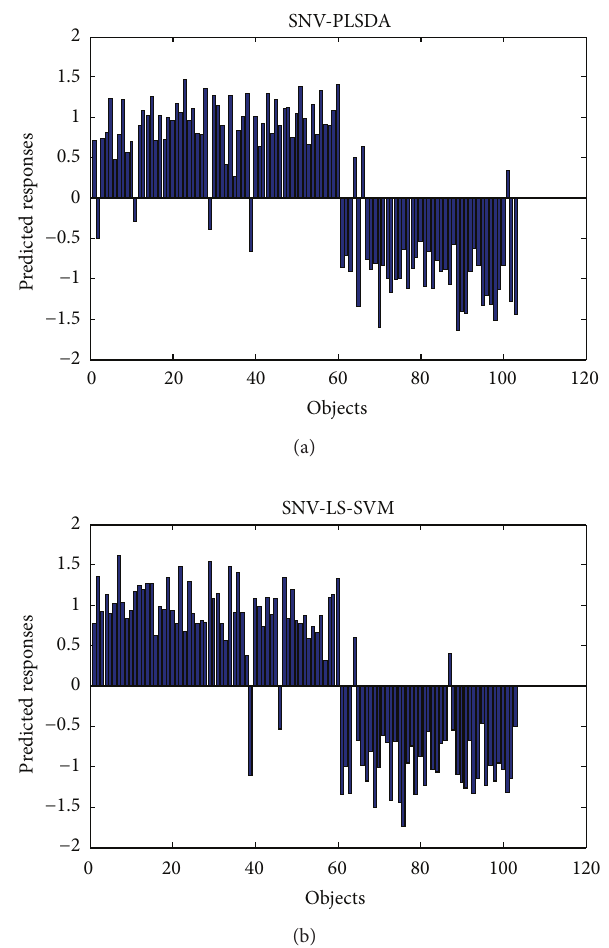
Figure 4: The predicted response values by SNV-PLSDA and SNV- LS-SVM models. Objects 1–60 are regular (positive) objects and 61– 103 are aged (negative)